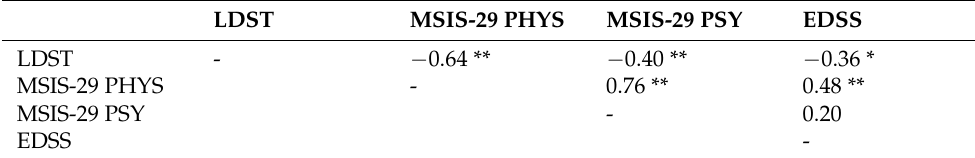
Table 4. The correlation coefficient for LDST, EDSS, and MSIS-29 in pwMS (N = 87). LDST MSIS-29 PHYS